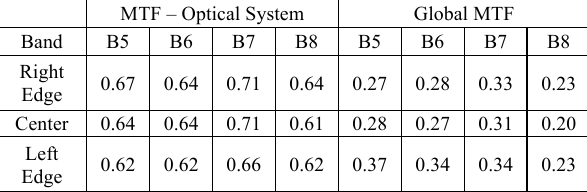
Figure 1. Simulation Image Metodology. Table 2. MUX MTF measured in the